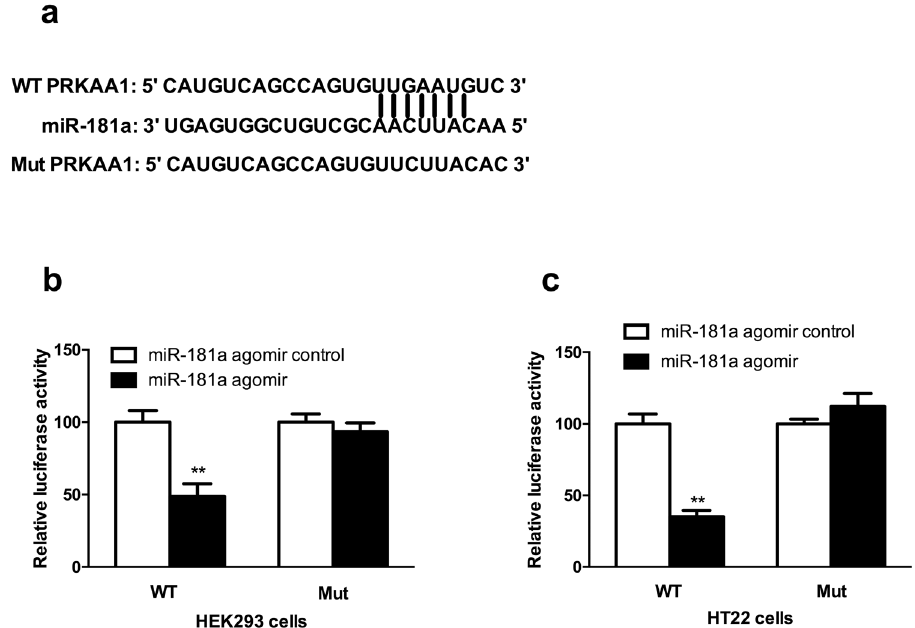
Figure 4. miR-181a mediated PRKAA1 expression by directly binding to its 3 ′ -UTR in HEK293T and HT-22 cell lines. ( a ) Complementary sequences between wild-type (WT) or mutant PRKAA1(Mut) 3 ′ -UTRs in the mRNA and miR-181a. ( b ) HEK293T cells or ( c ) HT-22 cells were co-transfected with the miR-181a agomir or miR-181a agomir control and the luciferase reporter construct containing the WT or Mut PRKAA1 3 ′ -UTR. For each experiment, the results were normalized to the luciferase activity detected in the cells transfected with the miR-181a agomir control and the WT PRKAA1 3 ′ -UTR. ** p < 0.01, compared with the WT + miR-181a agomir control group. n = 5 per group. All values are presented as means ±